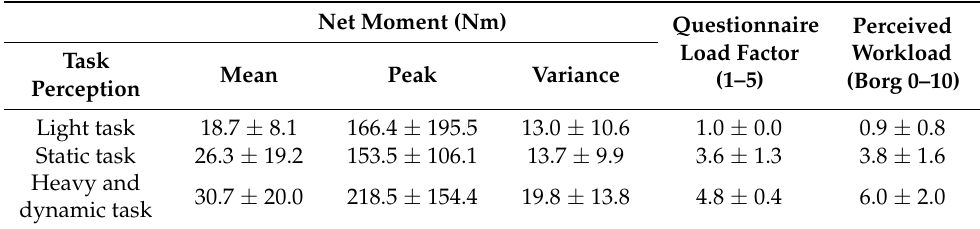
Table 5. Net moments, load ranking, and perceived workload for each task. The questionnaire workload factor with 1 = light work and 5 = very heavy task. The experienced workload (Borg CR-10) according to the subjects with 0 = not burdensome and 10 = extremely